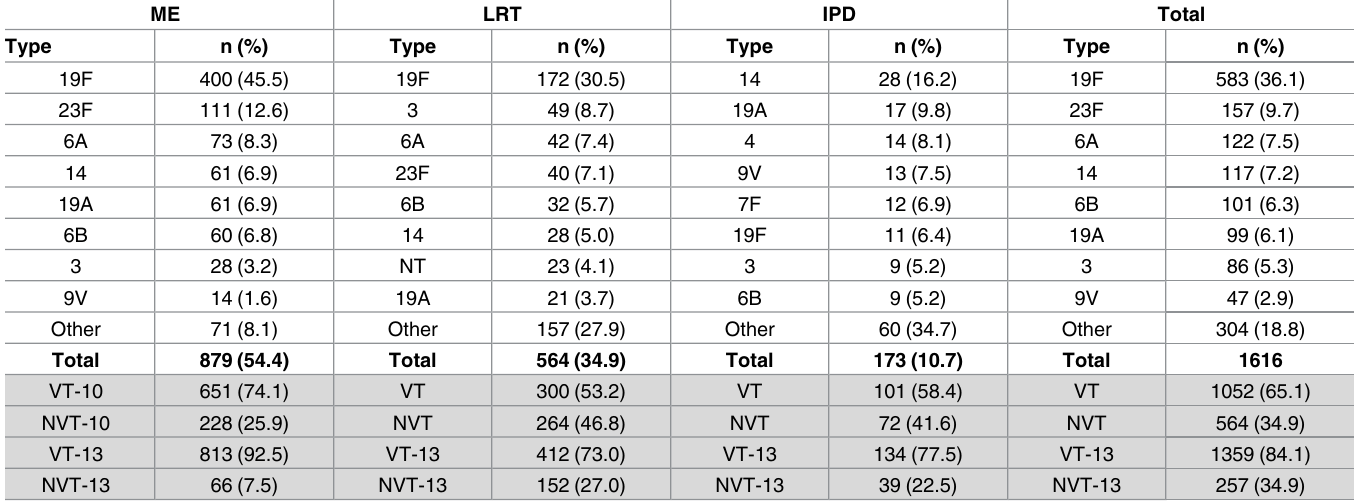
Table 2. Ranking of the eight most common serotypesaccording to infection site and their proportions (%) and of VTs and NVTs according to sampling site.